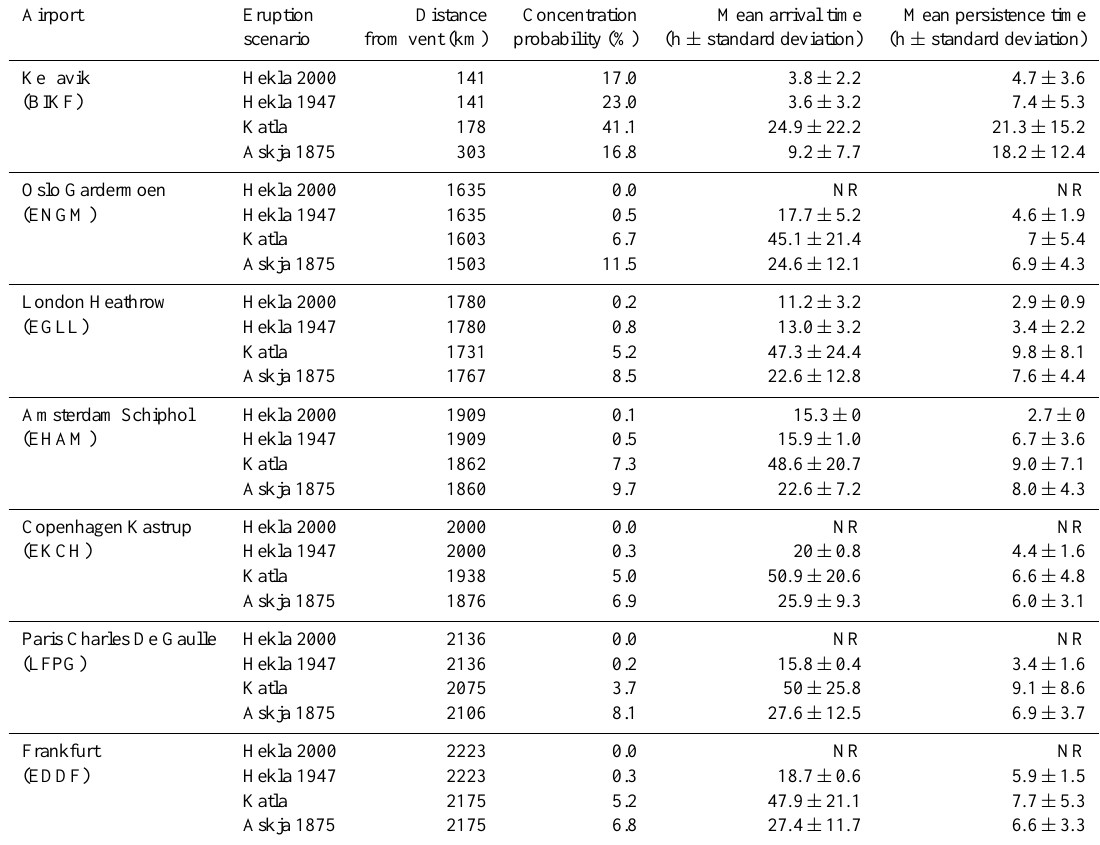
Table 5. Probabilities, mean arrival time and mean persistence time for a concentration of 2mgm − 3 for all FL combined above the selected airports shown in Fig. 1. NR: not reached.